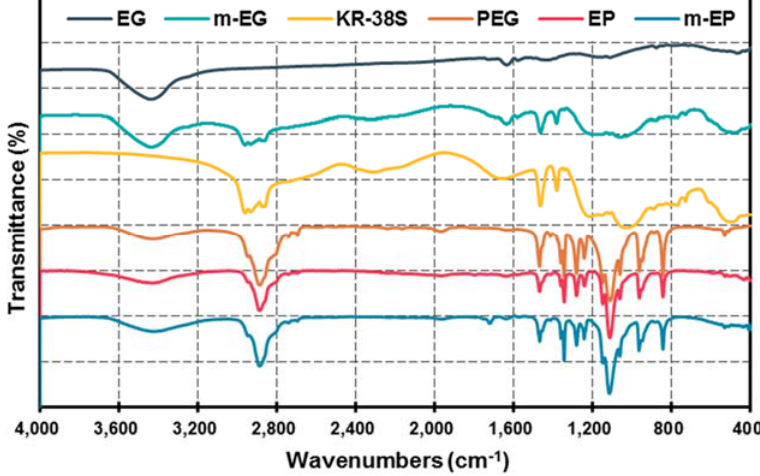
Figure 5. Fourier transform infrared (FT ‐ IR) spectra of EG, the modified EG matrix (m ‐ EG), KR ‐ 38S, PEG, EP, and m ‐ EP.